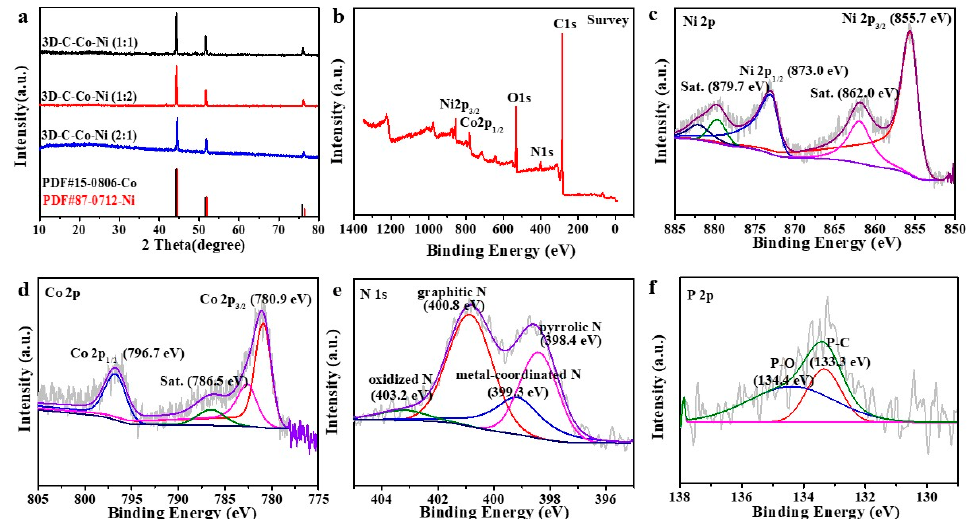
Figure 2. ( a ) XRD pattern; ( b ) survey XPS spectrum; and ( c ) Co2p, ( d ) Ni2p, ( e ) N1s, and ( f ) P2p spectra.